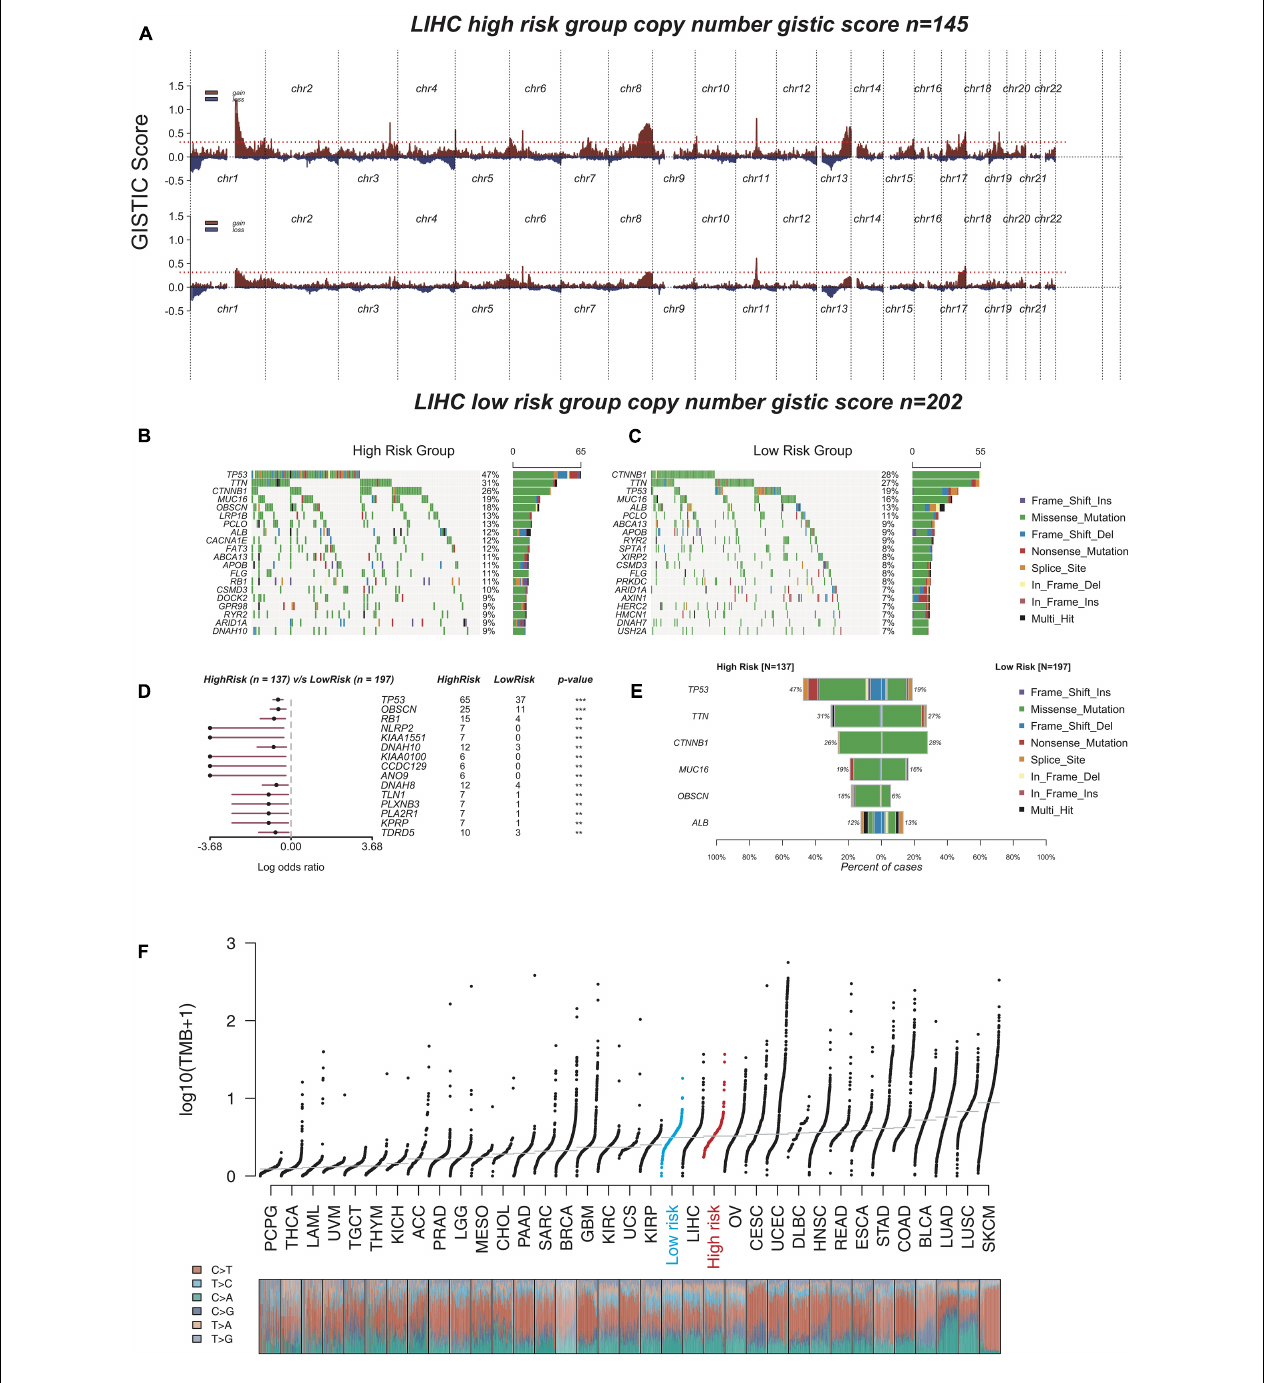
FIGURE 6 | The analysis of genomic aberrations in high-risk group and low-risk group. (A) Recurrent copy number aberrations of high-risk group and low-risk group in TCGA cohort. Regions of recurrent copy number amplifications (red) and deletions (blue) were above and below baseline (0.0), respectively, in the targeted array were identified by GISTIC 2.0. (Red line represented GISTIC score of 0.3). (B,C) Oncoplot displaying the somatic landscape of high-risk group (B) and low-risk group (C) . Genes were arranged according to their mutation frequency. The Y -axis was the gene name and the abscissa was the sample name. Different colors represented different mutation types. (D) Forest plot showed differentially mutated genes between high-risk group and low-risk group. The adjacent table included the number of samples in high-risk group and low-risk group with the mutations in the highlighted gene. The p -value indicated significance threshold: *** p < 0.001; ** p < 0.01; Fisher’s exact test. (E) Co-bar plots showed the most recurrently mutated genes in high-risk group and low-risk group. (F) The distribution plot shows tumor mutation burden (TMB) distribution of different cancer types. Liver hepatocellular carcinoma (LIHC) patients were divided into low-risk group and high-risk